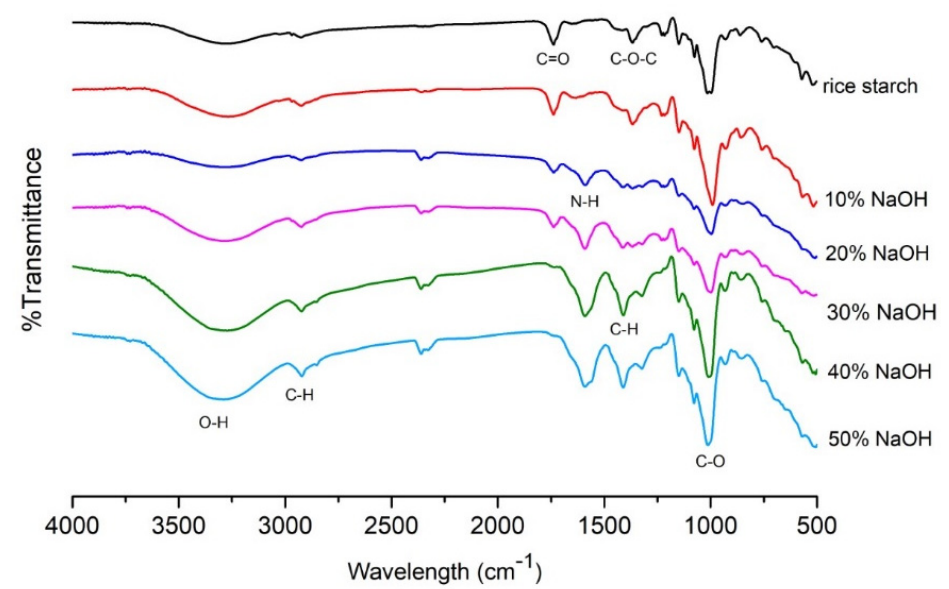
Figure 2. FT-IR spectra of rice starch film and CMSr films synthesized with 10%, 20%, 30%, 40%, and 50% concentrations.